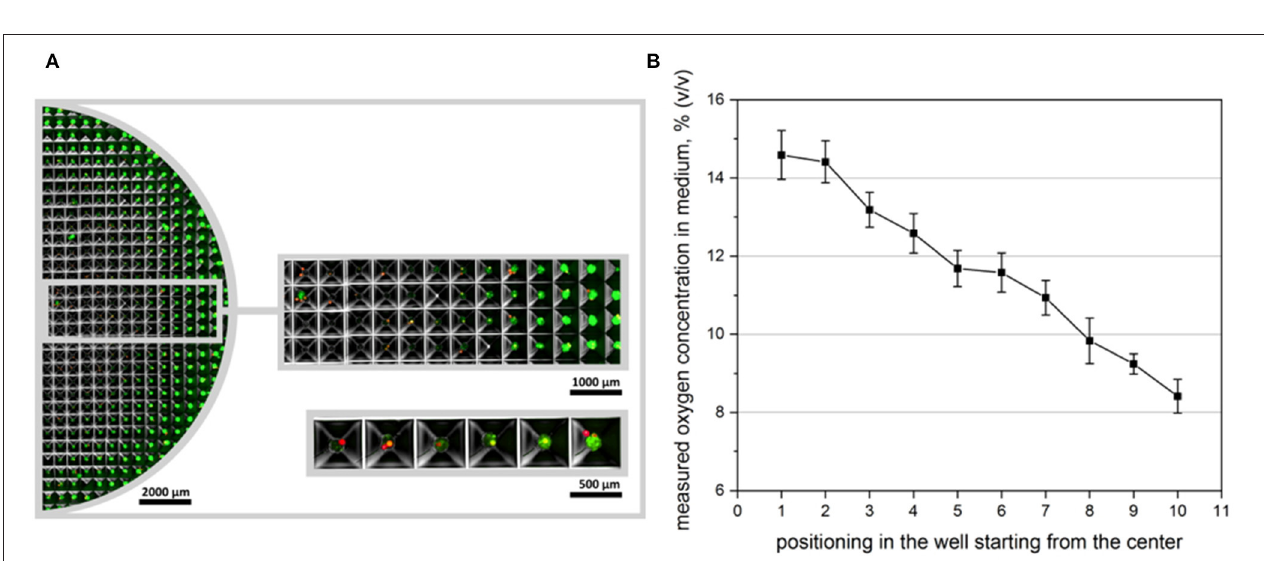
FIGURE 6 | Oxygen measurement in microstructured wells. (A) Overview over half the microstructured well with seeded oxygen sensitive microbeads. CpoX beads (red) were placed in the microwells previously to reporter cell seeding. 100 × 10 4 cells/multiwell are displayed 24h after cell seeding. (B) Accordingly oxygen concentrations in different microwells were measured. Position 1 represents microwells mostly in the center, while position 10 represents wells at the outer edge of the well. Measurements were taken in even distances in dependence of the readability of the applied microbeads. A clear gradient in oxygen availability could be monitored as confirmed by reporter cell